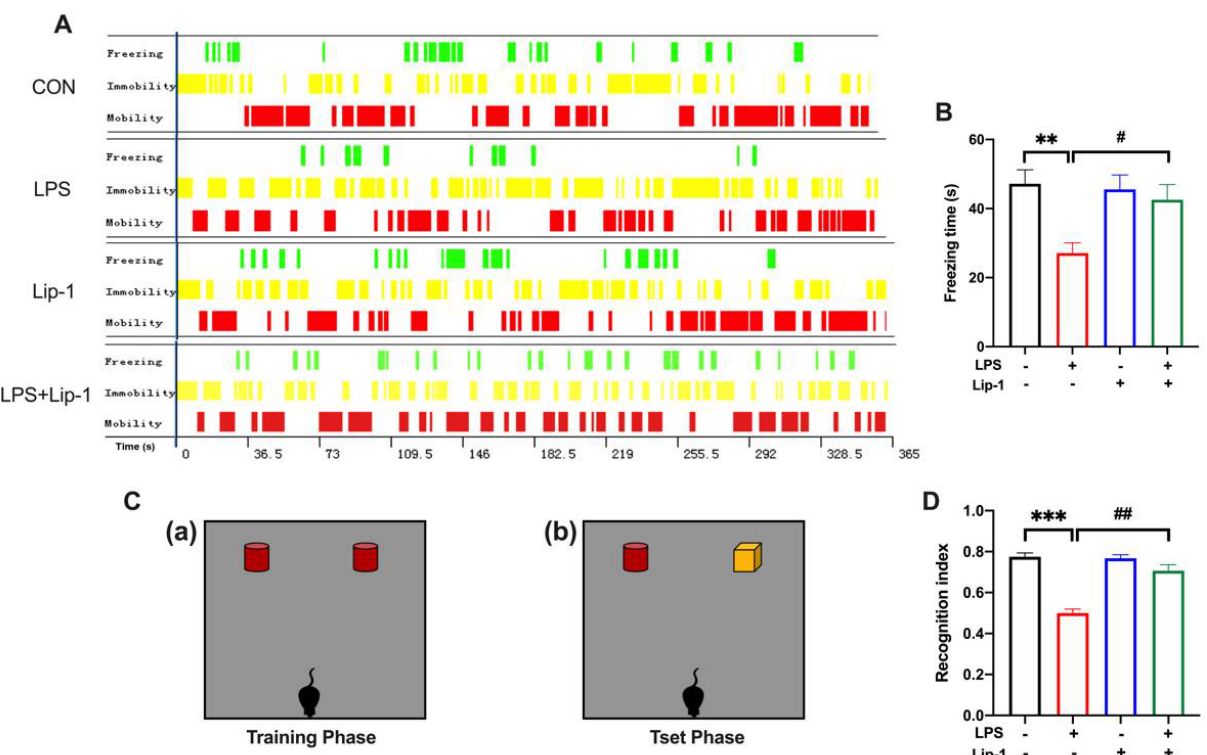
Figure 3. Liproxstatin-1 improved the behavioral performance in the contextual fear conditioning and novel objective recognition test after exposure to LPS in mice. ( A ) Representative time distribution of freezing, immobility and mobility in the four groups of mice. ( B ) The freezing time during the contextual fear conditioning test ( n = 12). ( C ) The schematic diagram for the ( a ) training phase and ( b ) test phase in the novel objective recognition test. ( D ) The recognition index in the test phase ( n = 12). Data are expressed as mean ± SE. ** p < 0.01, *** p < 0.001 vs. CON group; # p < 0.05, ## p < 0.01 vs. LPS group.